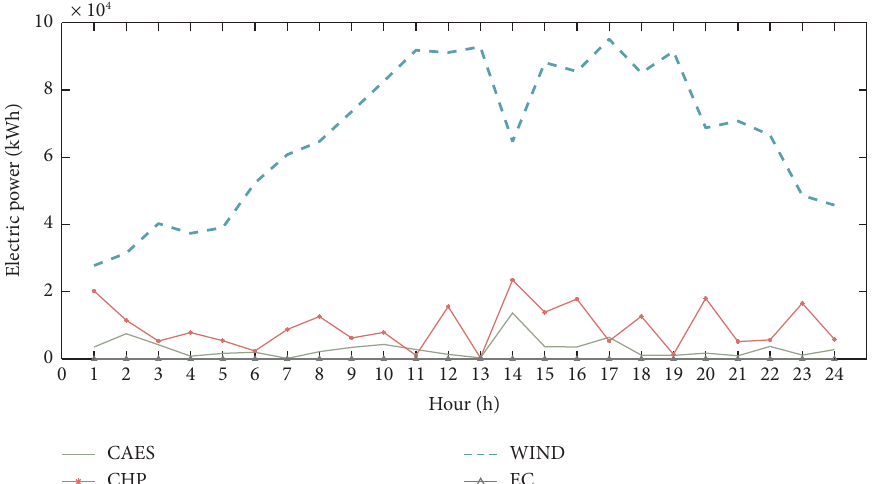
Figure 15: Power dispatch in